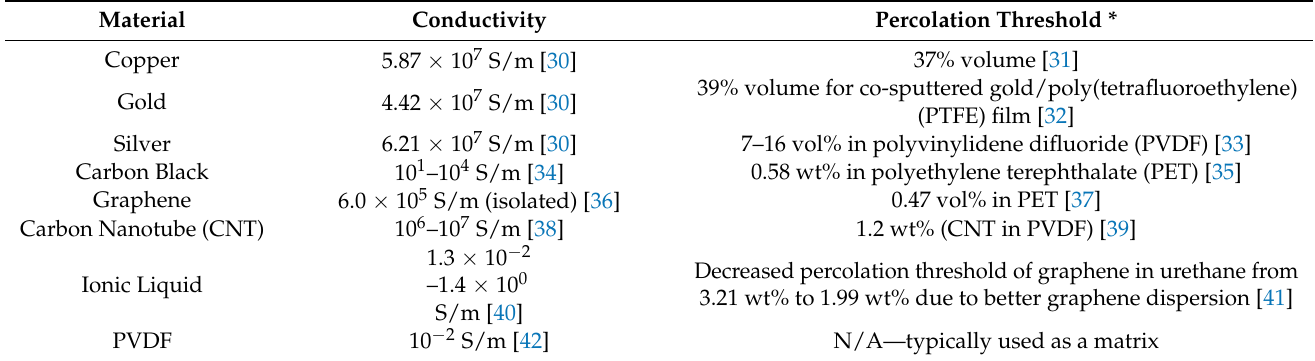
Table 1. Conductive materials used in smart textiles, their electrical conductivity and percolation threshold.